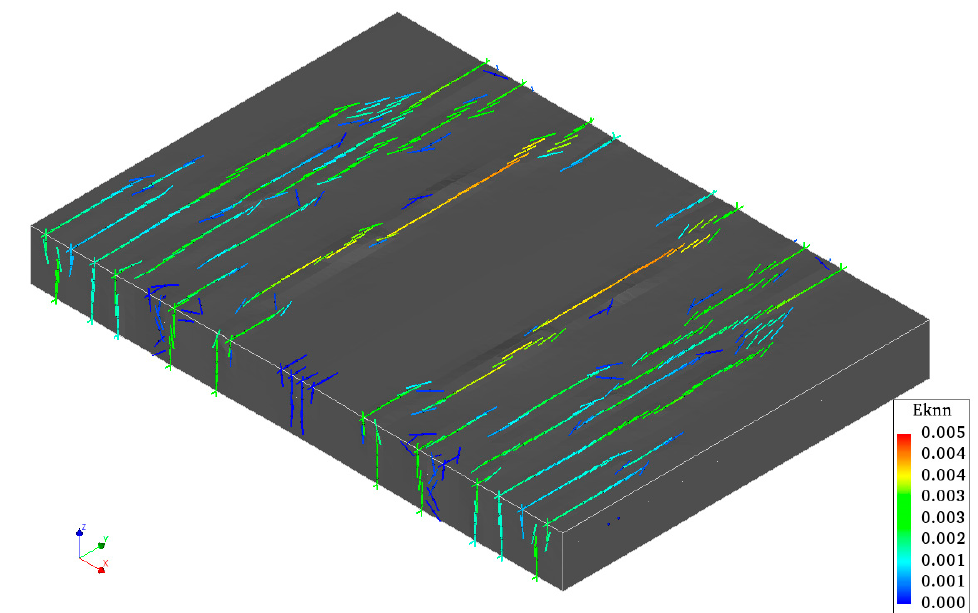
Figure 10. Development of the randomly occurring crack pattern in CRCP segment without active crack